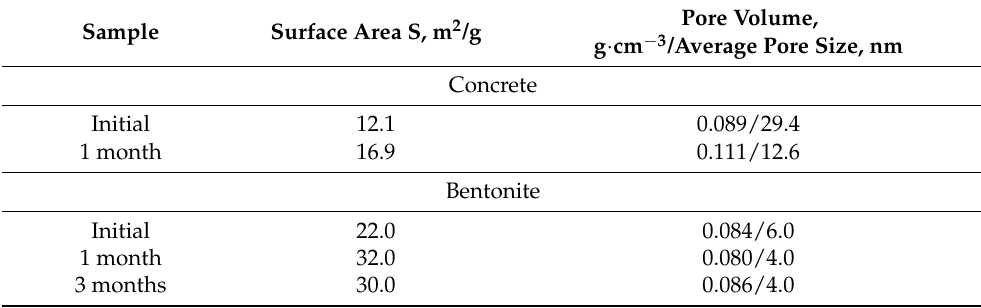
Table 1. The surface characteristics of the investigated concrete and bentonite